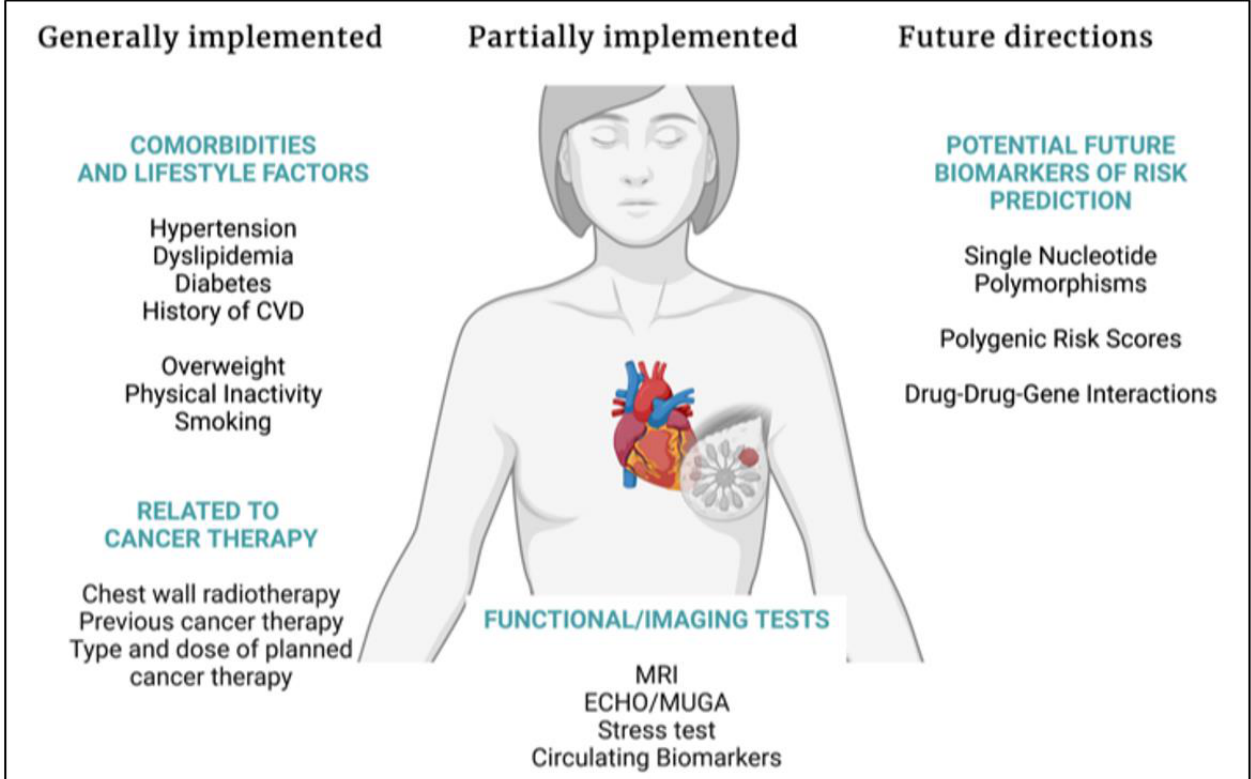
Figure 1. Summary of factors to be assessed concordantly with oncological treatment planning. Abbreviations: CVD: cardiovascular disease, ECHO: echocardiogram, MRI: magnetic resonance imaging, MUGA: multigated acquisition scan. Created with BioRender.com.